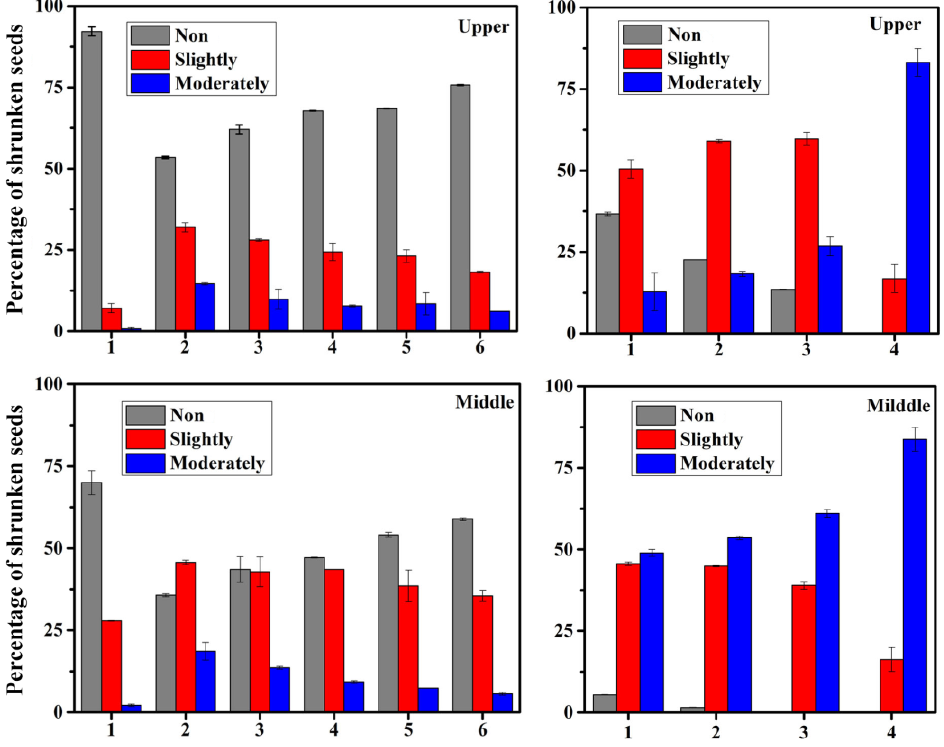
Figure 6. Protein amounts of amylose/amylopectin synthesis key enzymes in starches from non-shrunken (N), slightly shrunken (S), and moderately shrunken seeds (M). The protein amount is standardized by milligrams of